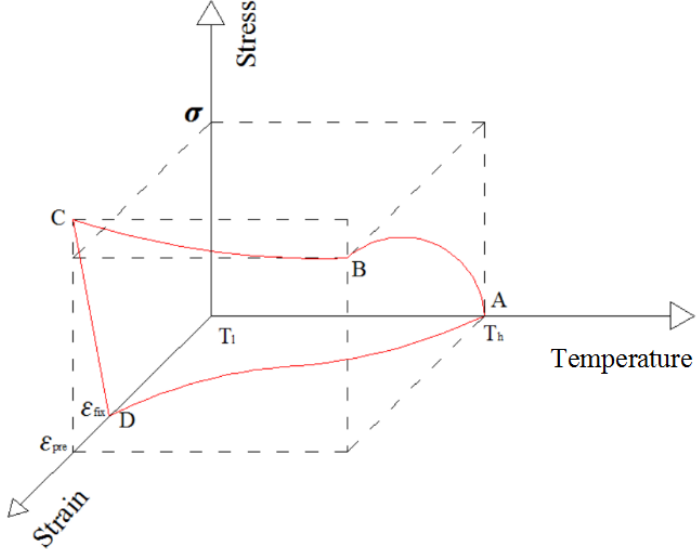
Figure 2. 3D stress–strain–temperature diagram illustrating the thermomechanical behavior of SMPs.